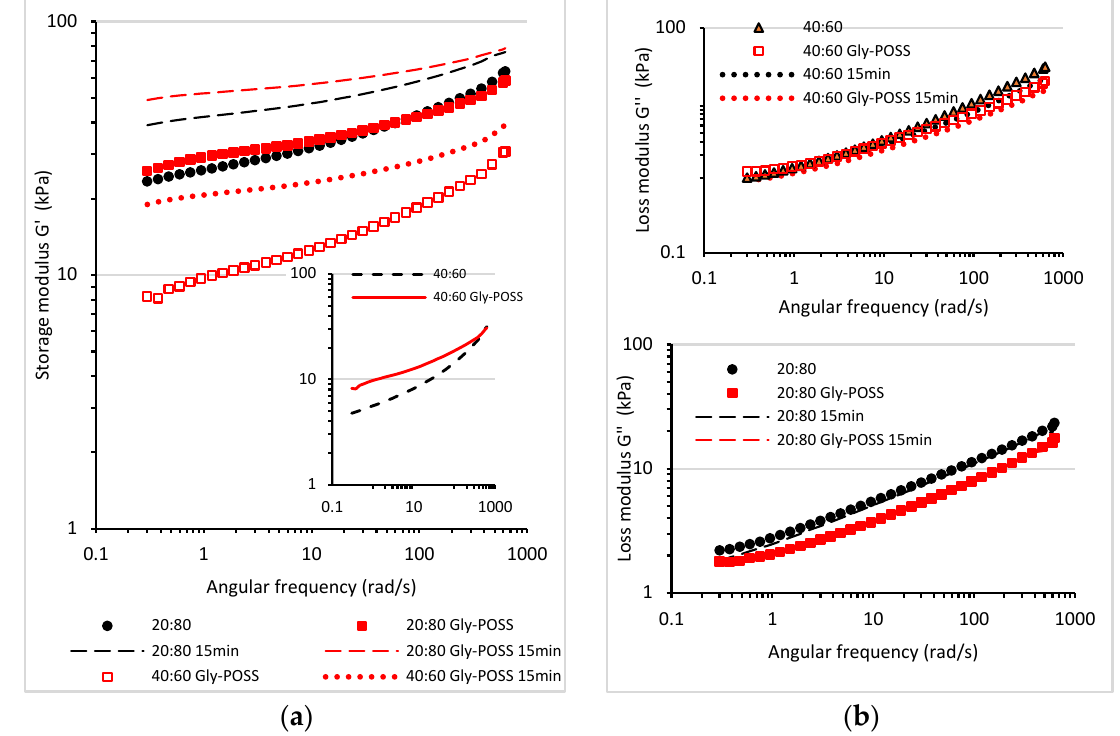
Figure 4. Influence of compression molding during 15 min at 160 °C on the viscoelastic properties of molten PLA/ENR/Gly-POSS blends . Storage shear G’ modulus ( a ) ; loss shear G’’ modulus ( b ).